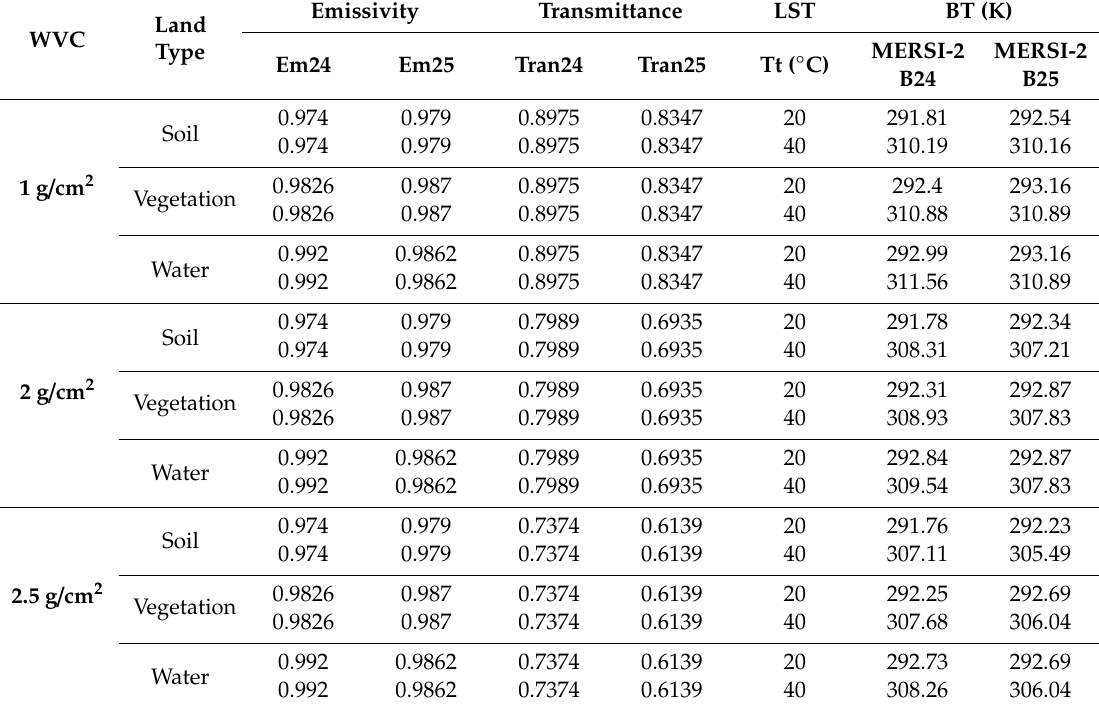
Table 4. The simulation of atmosphere transformation at